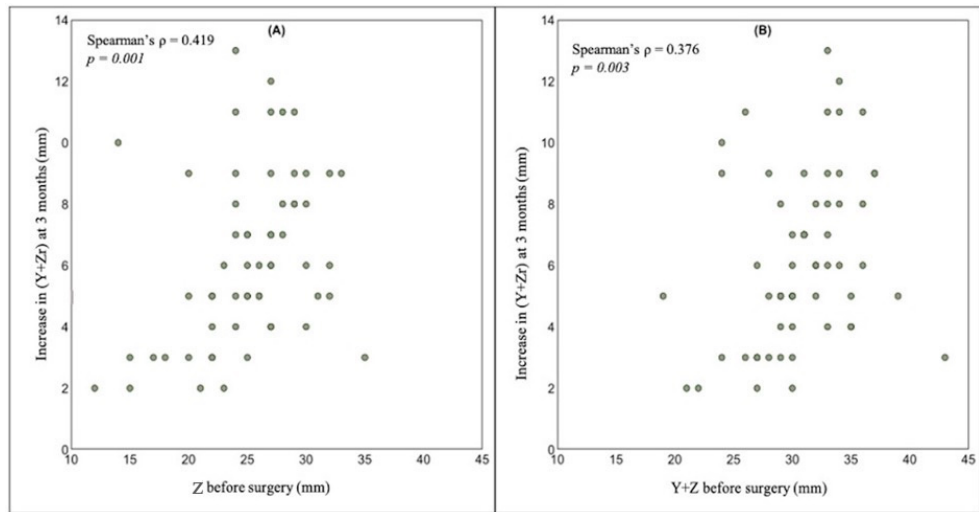
Figure 5. The positive relationship between (Y + Zr) values, measured three months after hysteroscopic metroplasty, and Z ( A ) and (Y + Z) ( B ) values measured before surgery.